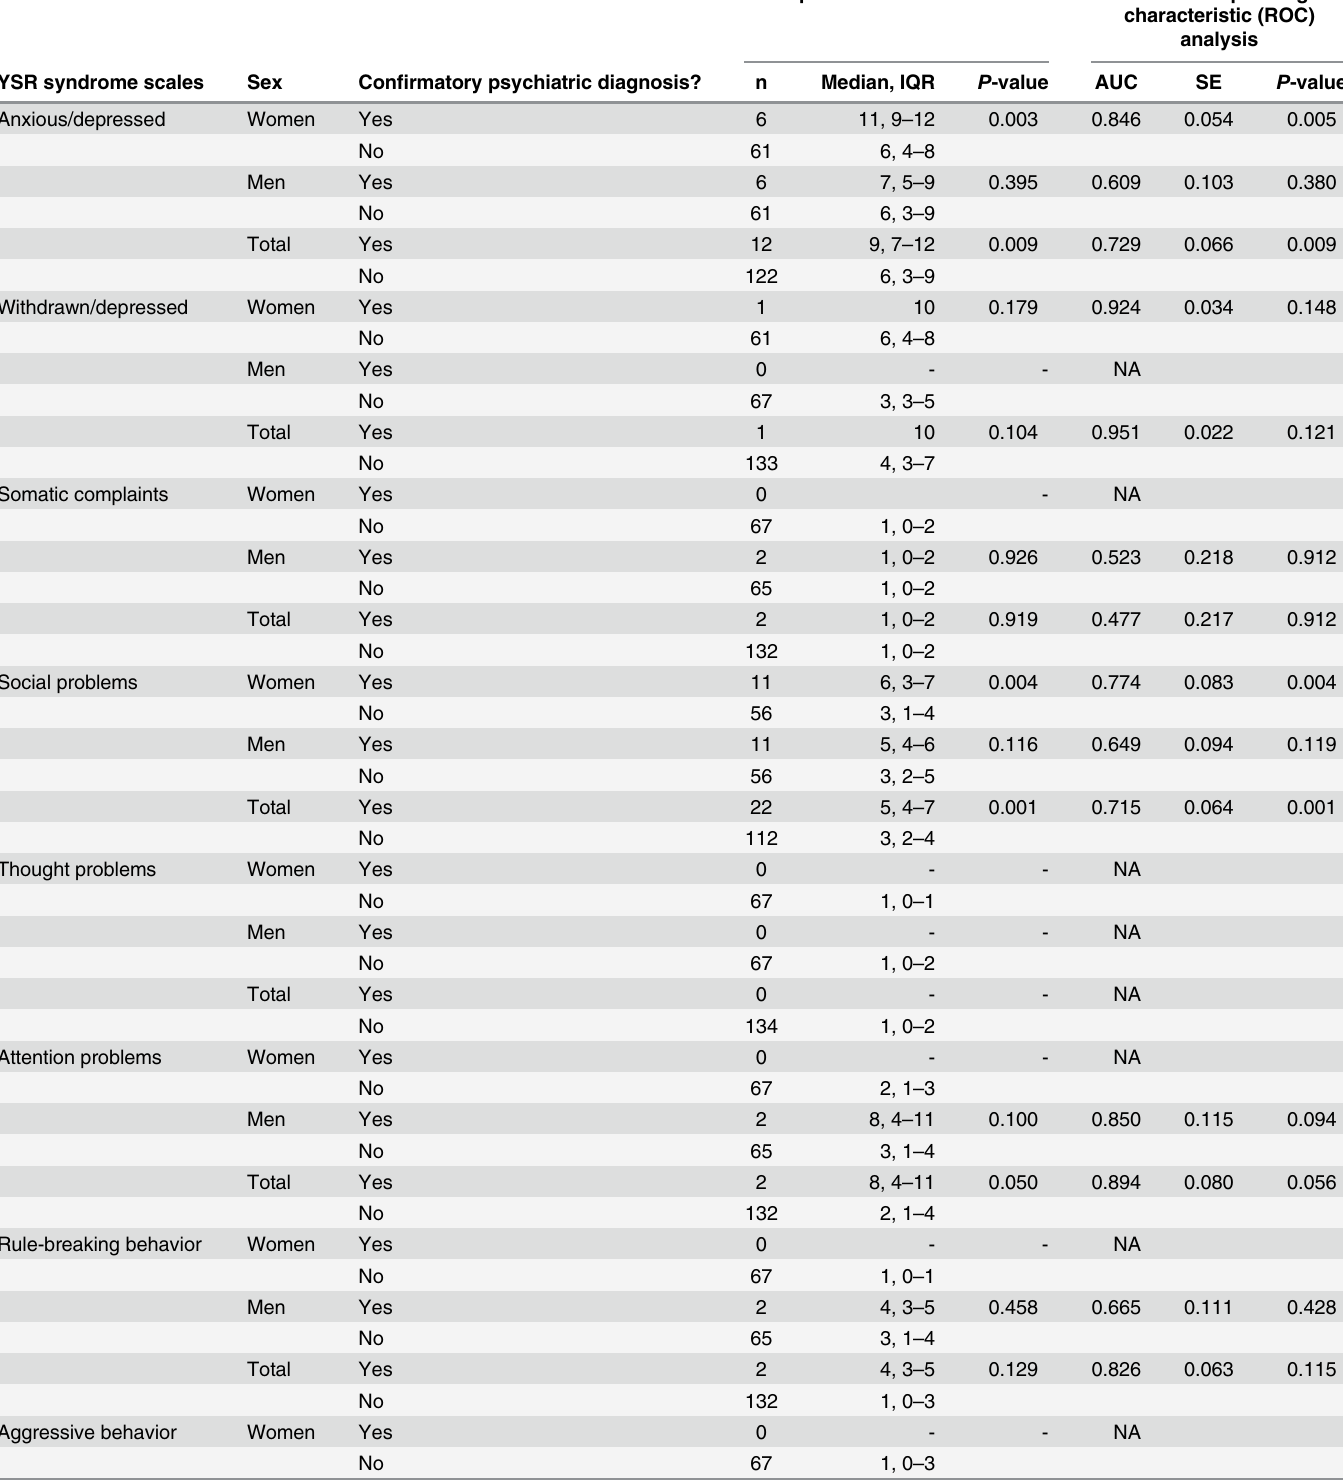
Comparison of median